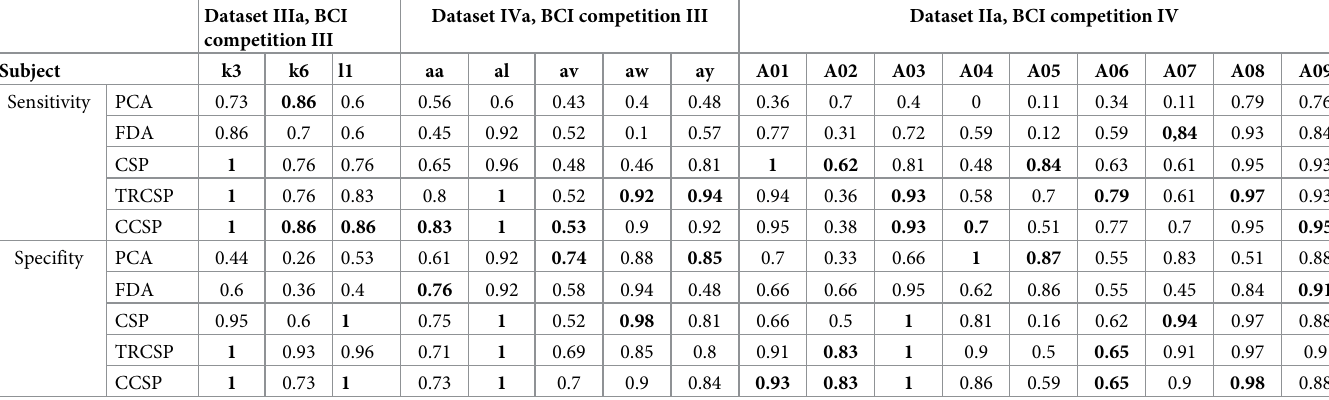
Table 2. Specificity and sensitivity for all of datasets in two-class problem (Best values are in boldface). Dataset IIIa, BCI competition III